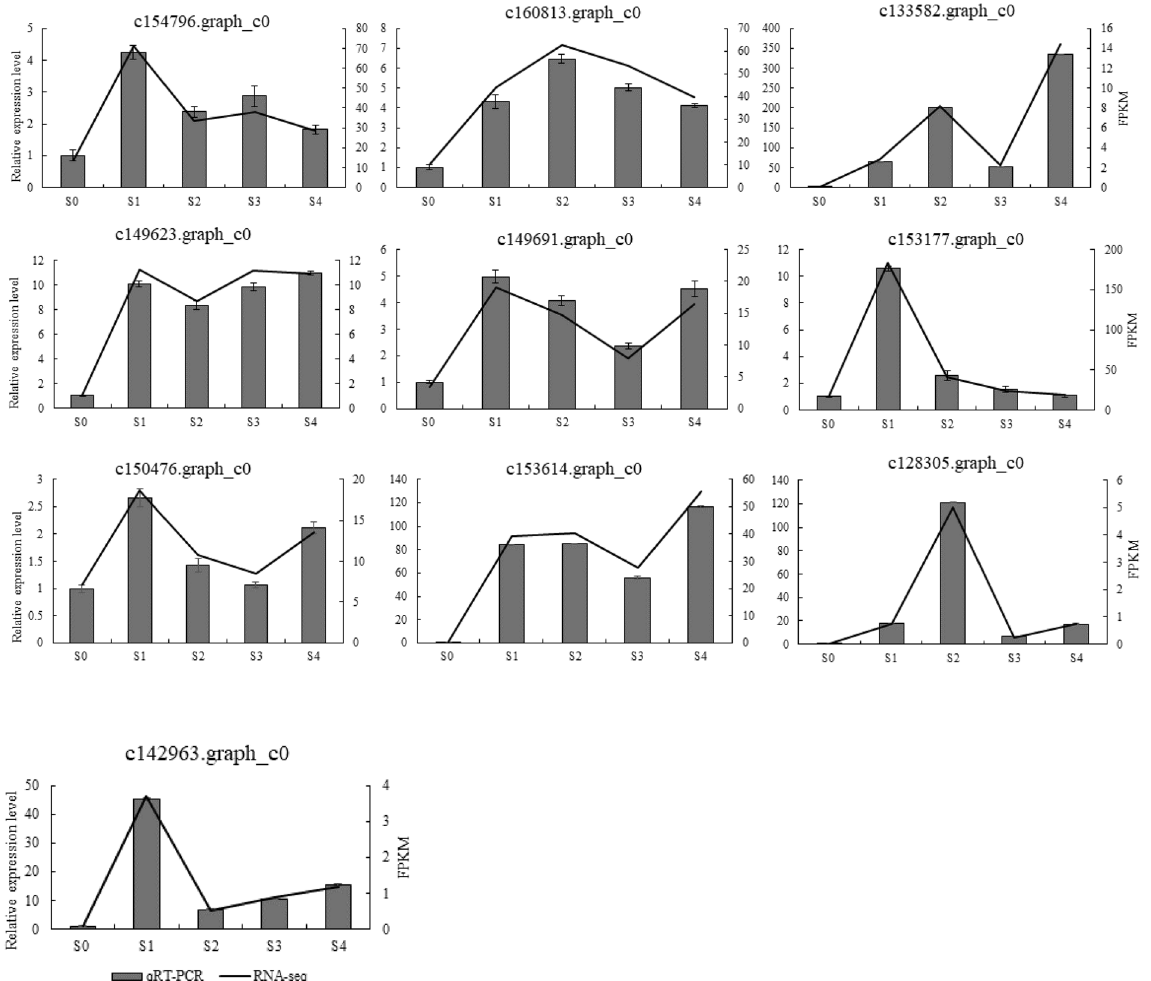
Figure 7. The relative expression levels of 10 DEGs based on RNA-Seq and